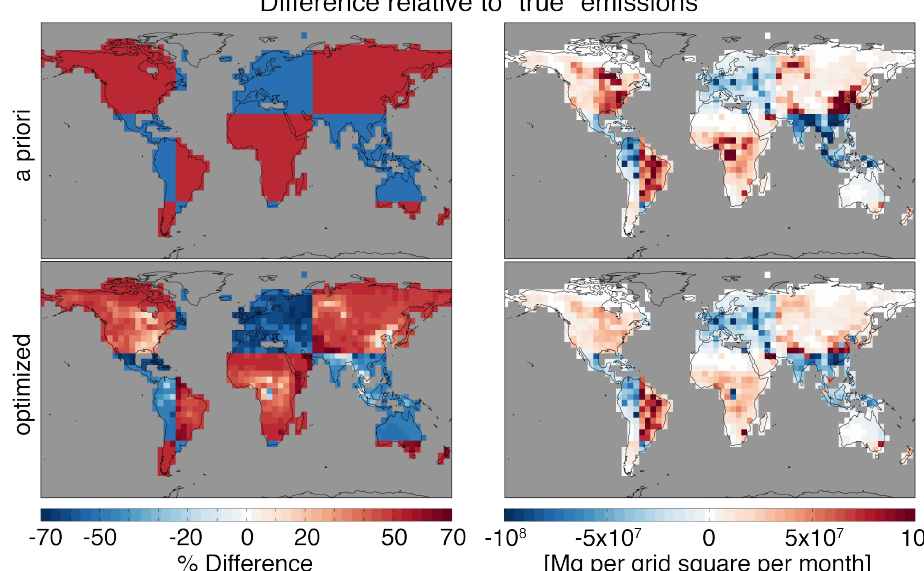
Fig. 8. Relative (left) and absolute (right) error of a priori (top) and optimized (bottom) methane emissions. Red and blue represent over and underestimates respectively. Gray represents regions covered by ocean or